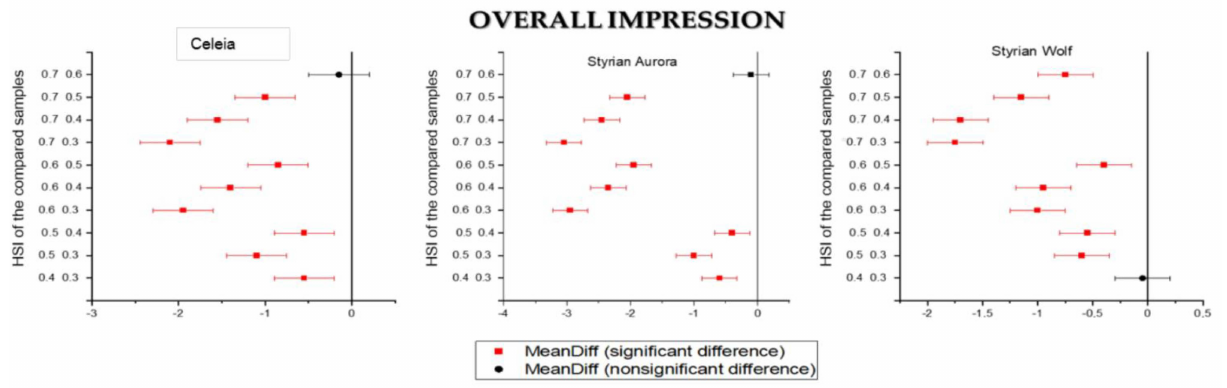
Figure 3. Tukey’s comparison plots for overall impression of beer samples.